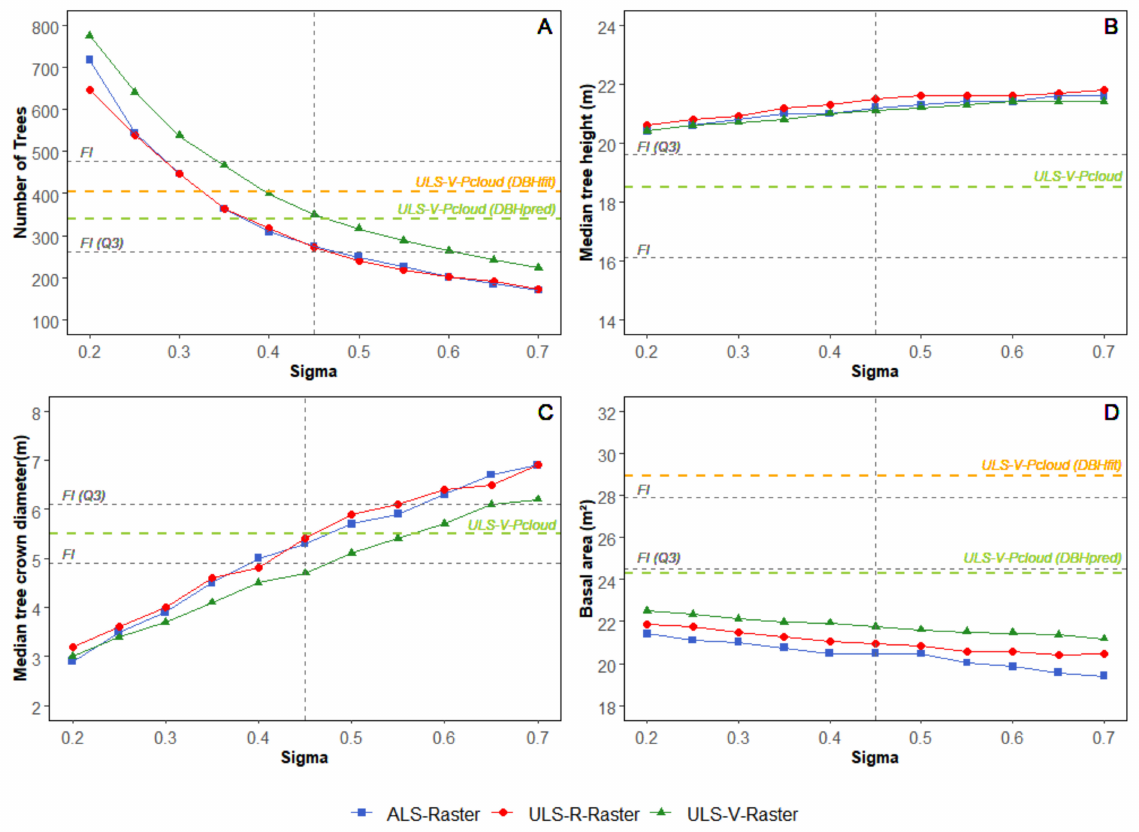
Figure 16. Sensitivity analysis of the raster-based ITD (SEGMA) to sigma value, i.e., the parameter of the Gaussian filter affecting the magnitude of CHM smoothing. Each colored line represents changes in estimated ( A ) number of trees; ( B )